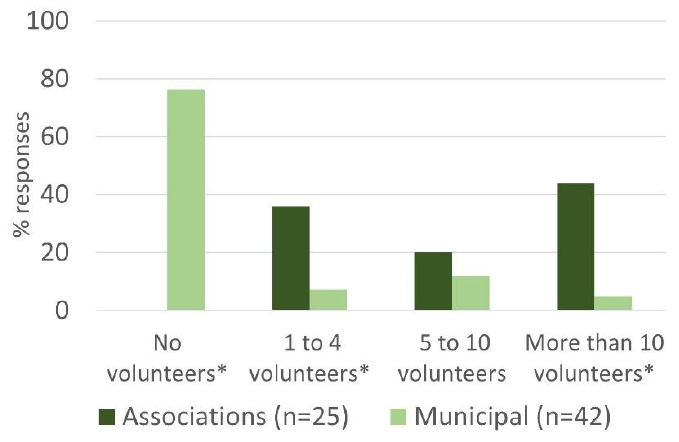
Figure 4. Number of volunteers working at animal shelters. Data gathered by a questionnaire targeted to Municipal and Non-Municipal shelters (Associations) in March/April 2021. * Indicates statistically significant difference between Municipal shelters and Animal Associations (d.f. 1, p < 0.05).